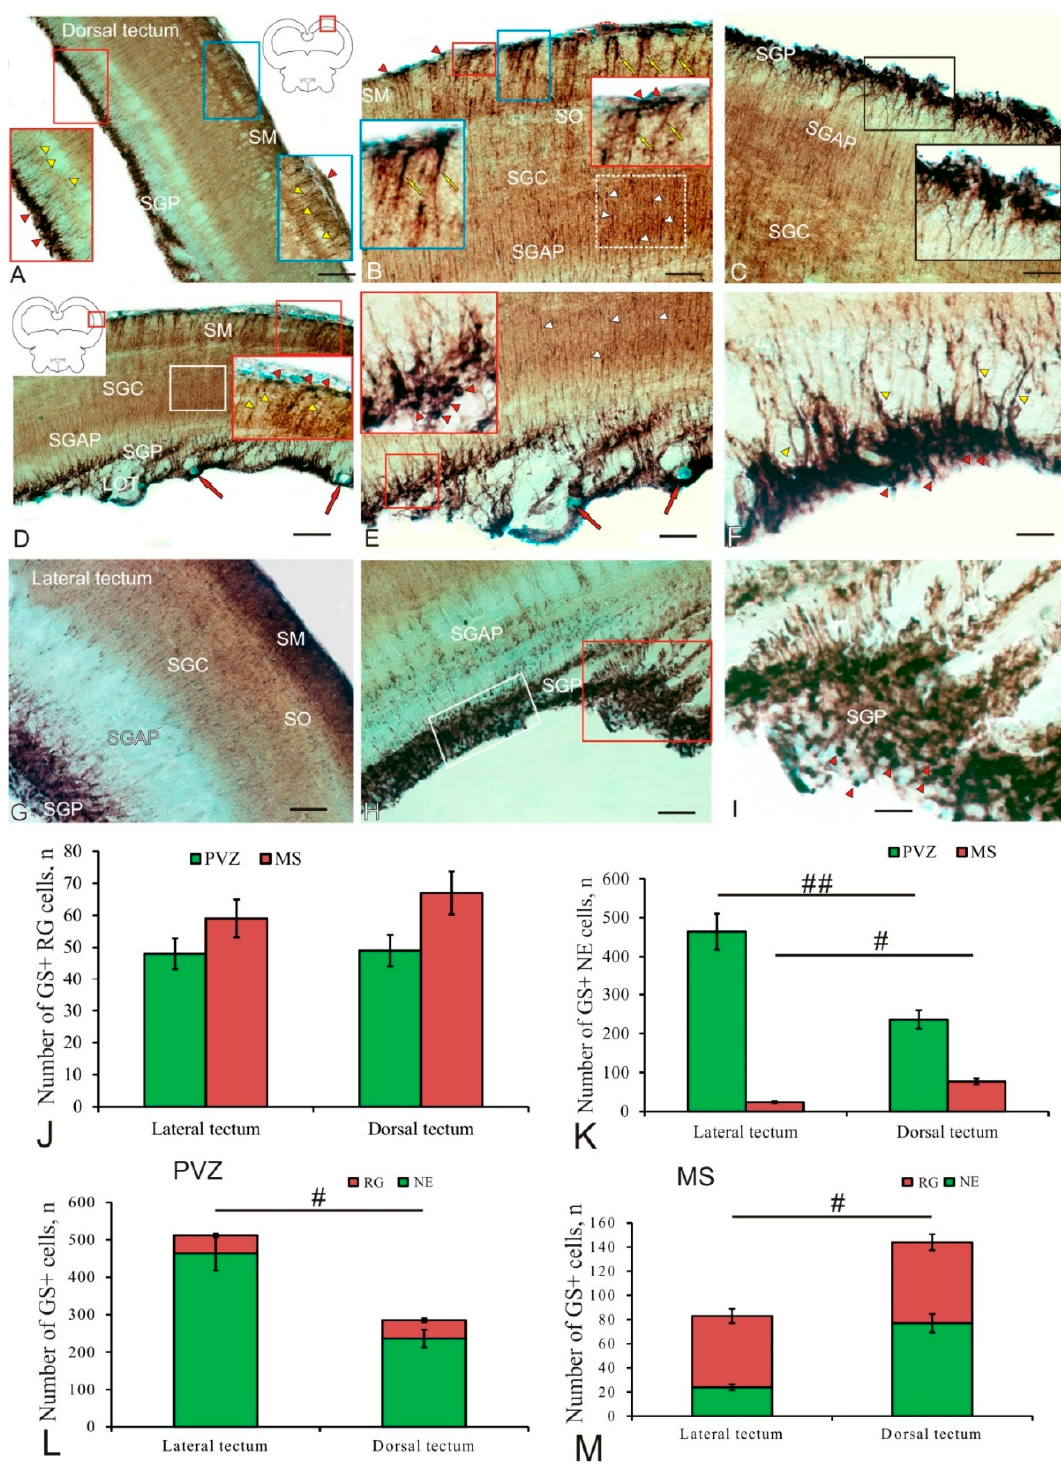
Figure 2. Glutamine synthetase (GS) in the dorsal and lateral tectum opticum of trout, Oncorhynchus mykiss : ( A ) A general view of GS immunolabeling in the dorsal tectum; the pictogram in the red square shows the selected tectum area, GS+ neuroepithelial (NE) progenitors (red arrowheads) in the marginal layer (SM), and RG (yellow arrowheads) identified in the periventricular gray layer (SGP) (red inset). ( B ) Dorsal part of the tectum at a higher magnification; NE cells located singly (red arrowheads) or forming small clusters (red inset) in SM, clusters of GS+ RG cells (yellow arrows) with processes extending into the inner layers of the tectum (blue inset), and an increased